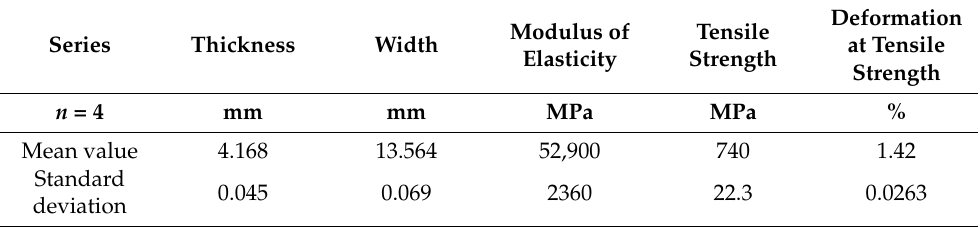
Table 1. Tensile testing results of test pieces with embedded optical fibre.